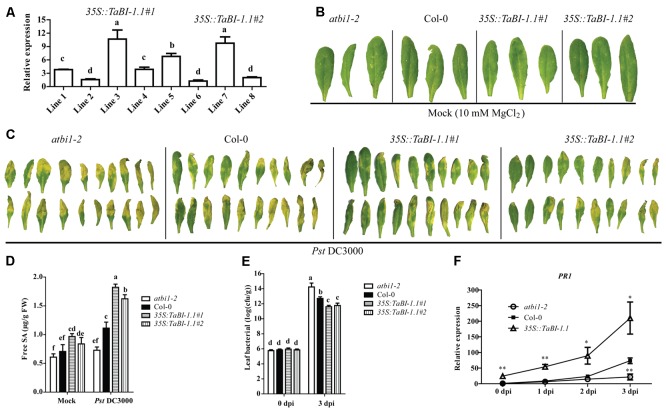
TaBI-1.1 transgenic Arabidopsis exhibited enhanced resistance to Pst DC3000. (A) qRT-PCR analysis of TaBI-1.1 transcripts in eight 35S::TaBI-1.1 transgenic lines. The line 6 with the lowest expression levels was set to “1.” Arabidopsis actin2 was used as a reference. Bacterial defense phenotypes on 4-week-old atbi1-2, Col-0, 35S::TaBI-1.1#1, and 35S::TaBI-1.1#2 plant leaves exposed to 10 mM MgCl2 (mock) (B) and Pst DC3000 (OD600 = 0.002) (C) observed at 3 dpi. (D) Free SA levels in atbi1-2, Col-0, 35S::TaBI-1.1#1, and 35S::TaBI-1.1#2 leaves exposed to 10 mM MgCl2 (mock) and Pst DC3000 (OD600 = 0.002) after 24 h. Different letters in bar graphs indicate significant differences. (E) The bacterial titre (log10) of atbi1-2, Col-0, 35S::TaBI-1.1#1, and 35S::TaBI-1.1#2 leaves at 0 and 3 dpi with Pst DC3000 (OD600 = 0.002). Different letters in bar graphs indicate significant differences. (F) qRT-PCR analysis showing the PR1 expression levels at 0, 1, 2, and 3 dpi with Pst DC3000 (OD600 = 0.002). The expression level of PR1 in Col-0 at 0 dpi was set to “1.” Arabidopsis actin2 was used as a reference. Asterisks indicate significant differences (∗P < 0.05 and ∗∗P < 0.01) compared with Col-0 (Student’s t-test). Error bars indicate SDs. All the data represent the means ± SDs of three independent biological replicates.